Question: What caption would you write for this figure?
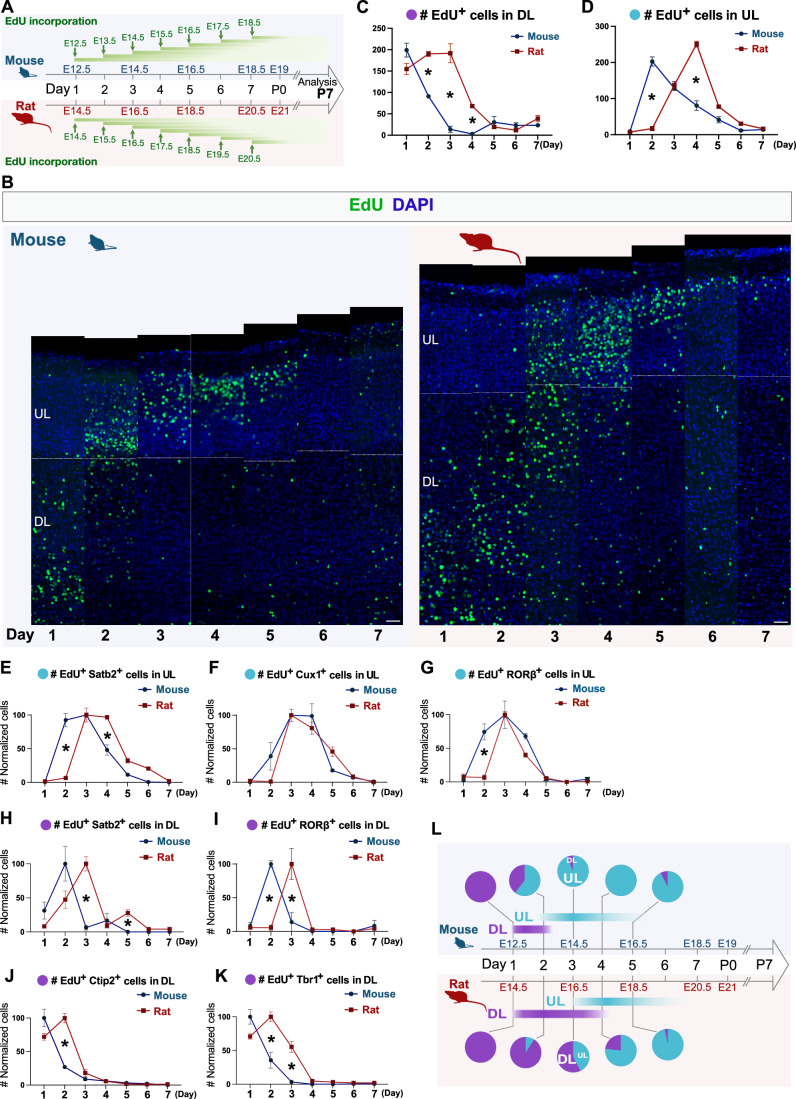
Answer: Birthdating of cortical excitatory neurons in mice and rats. ( A ) Experimental design for birthdating analysis in mice and rats, showing different timing of EdU injections from the onset until the end of neurogenesis. ( B ) Representative images of cortical columns in S1 with EdU-labeled neurons at the specified developmental stages. Scale bars: 50 μm. ( C , D ) Quantification of DL ( C ) and UL subtypes ( D ) labeled with EdU at different stages. Asterisks indicate statistical significance ( P < 0.05). P values in DL: Pmouse-rat day 2 = 1.60 × 10 −5 , Pmouse-rat day 3 = 1.56 × 10 −3 , Pmouse-rat day 4 = 5.30 × 10 −5 , in UL: Pmouse-rat day 2 = 2.84 × 10 −3 , Pmouse-rat day 4 = 9.61 × 10 −4 . ( E – K ) Normalized counts of neurons co-labeled for EdU and projection-specific markers, relative to the peak of EdU+ and marker+ cells. ( E ) Satb2-positive UL neurons, Pmouse-rat day 2 = 8.29 × 10 −4 , Pmouse-rat day 4 = 4.03 × 10 −3 , ( F ) Cux1-positive UL neurons, ( G ) RORβ-positive neurons located in UL, Pmouse-rat day 2 = 2.09 × 10 −2 , ( H ) Satb2-positive DL neurons, Pmouse-rat day 3 = 6.87 × 10 −3 , Pmouse-rat day 5 = 2.76 × 10 −2 , ( I ) RORβ-positive DL neurons, Pmouse-rat day 2 = 1.48 × 10 −4 , Pmouse-rat day 3 = 4.35 × 10 −2 , ( J ) Ctip2-positive DL neurons, Pmouse-rat day 2 = 5.76 × 10 −3 and ( K ) Tbr1-positive DL neurons, Pmouse-rat day 2 = 1.53 × 10 −2 , Pmouse-rat day 3 = 2.49 × 10 −2 . ( L ) Summary of neuronal birthdating in mice and rats, highlighting species-specific differences in the timing of DL and UL neuron production. Data are presented as the mean ± standard error of the mean (SEM). n = 3 biologically independent samples per group in ( C , D , E – K ). Asterisks indicate statistical significance ( P < 0.05). Statistical analysis was performed using Welch’s t test, with detailed results available in Dataset EV1 .